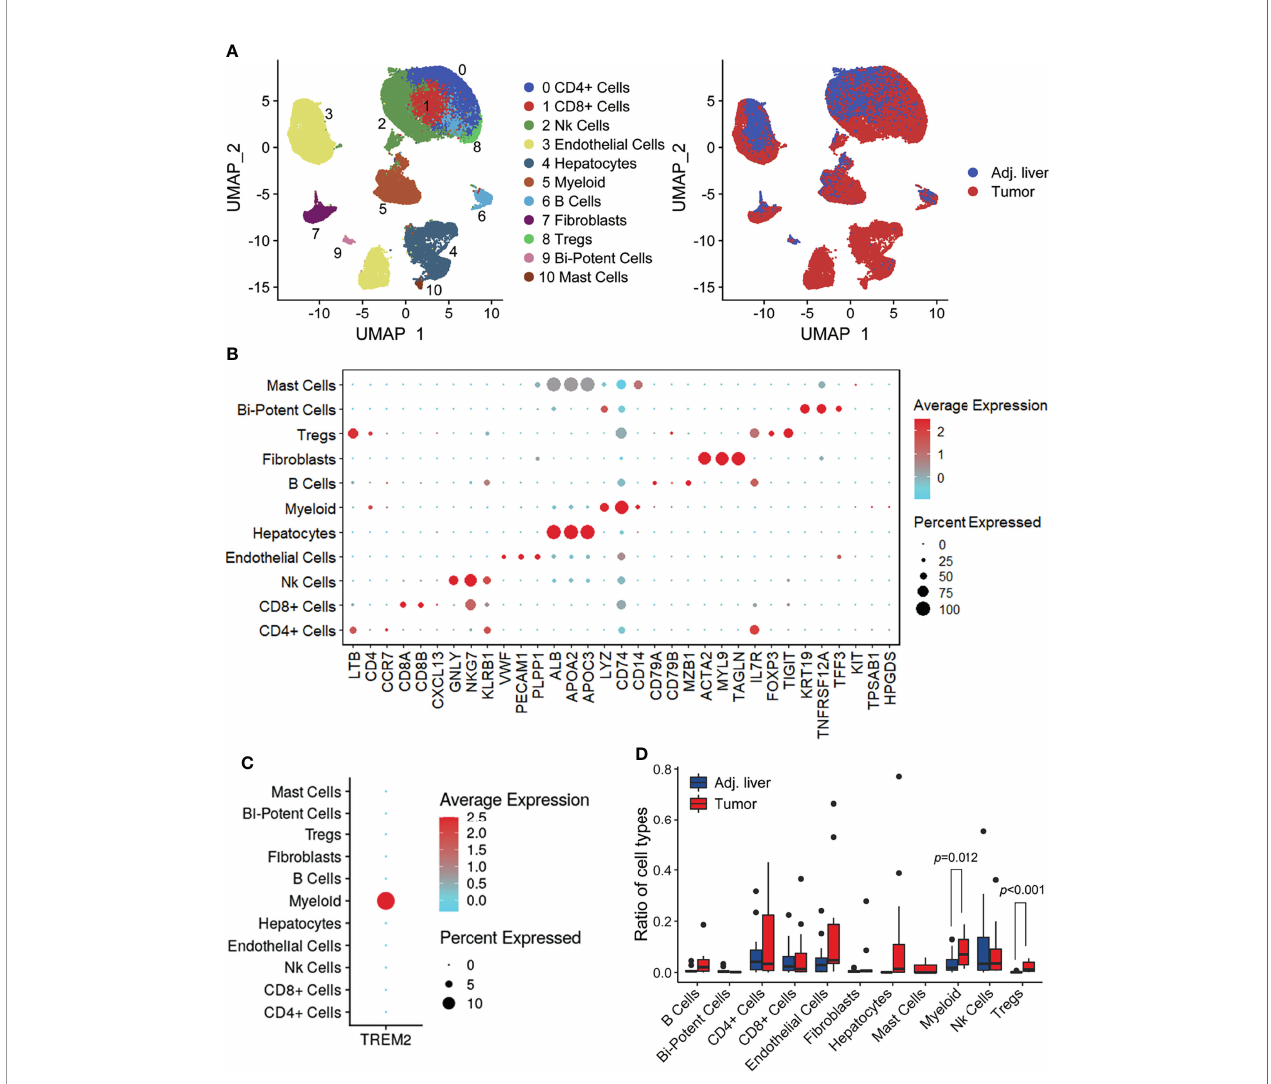
FIGURE 1 | Overview of in fi ltrating cell types in HCC. (A) UMAP projection of single cells derived from 14 HCC patients colored by cell clusters (left) and tissue origin (right). (B) Bubble heatmap depicting the expression levels of cluster-speci fi c marker genes. The dot size indicates the fraction of expressing cells, and dots are colored based on average expression levels. (C) Dot plot showing the expression levels of TREM2 in the major cell types. (D) Box plot illustrating the fractions of the indicated cell types (divided by the total cell number) in adjacent liver and tumor tissues. Signi fi cance was determined using unpaired Wilcoxon